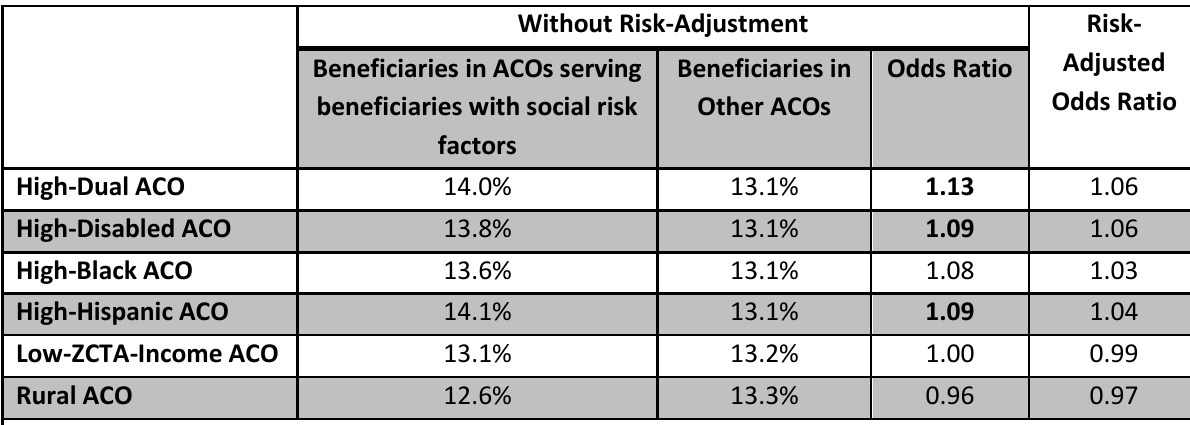
Table 9.5: ACO Social Risk Factors and Performance on Medicare Shared Savings Program Readmission Measure (2014)